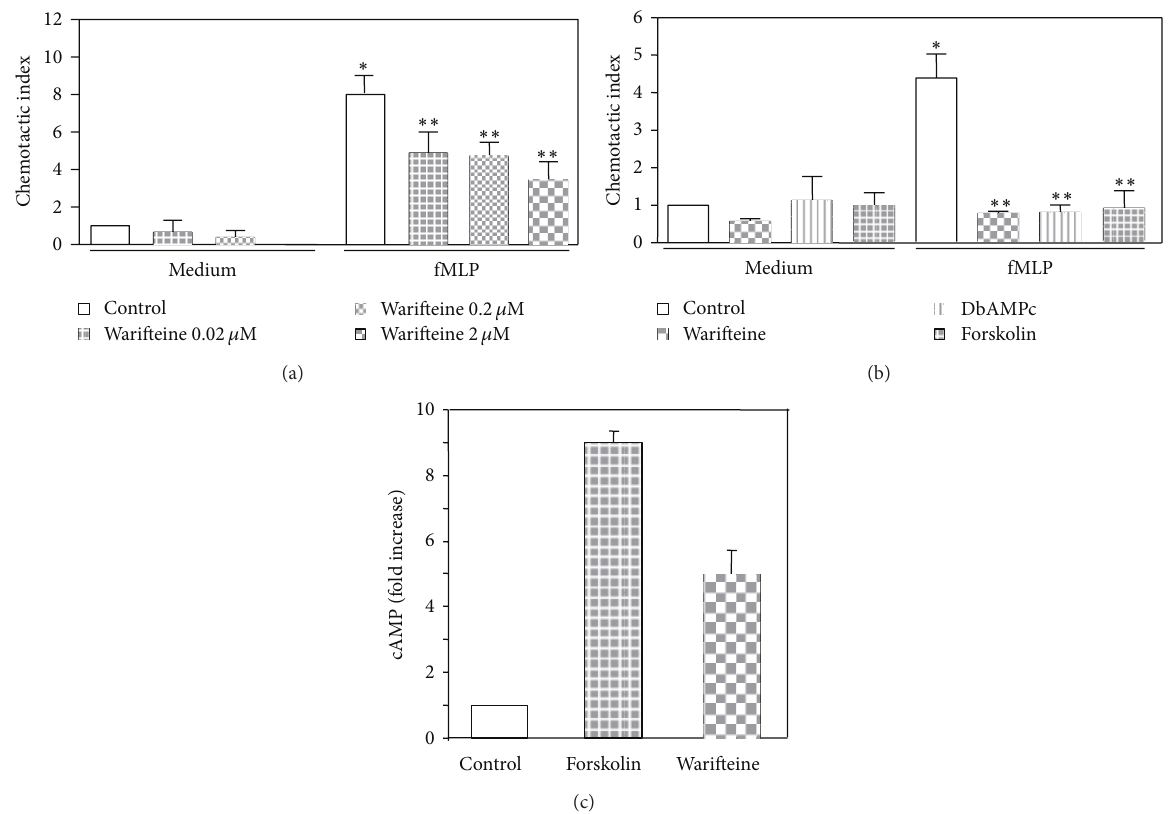
Figure 7: Inhibition of neutrophil migration in the presence of warifteine and induction of increased intracellular cAMP levels. (a) Solutions of chemoattractant (fMLP) were added to a 24-well plate. A neutrophil suspension was obtained and either left untreated or incubated with the indicated doses of warifteine. Theses samples were added to transwell inserts which were placed into the fMLP filled wells. Cell migration was determined by counting cell number in the outside (fMLP) compartment using a hemocytometer. The chemotactic index was calculated for each sample. Data shown indicate the mean value obtained from two independent experiments. ∗ 𝑃 ≤ 0.05 when comparing untreated and fMLP-stimulated cultures; ∗∗ 𝑃 ≤ 0.05 when comparing data from warifteine-treated and untreated cultures. (b) Samples obtained as described in (a) were incubated with warifteine, DbAMPc, or forskolin. Cultures were set up as in (a). Pretreated cell samples were added into a transwell insert placed in fMLP containing wells (outside compartment). The chemotactic index is shown. (c) Neutrophil cultures were incubated with either forskolin or warifteine. Control cultures received no pretreatment. Intracellular cAMP levels were measured by a competitive binding assay. Data indicate the fold increase of cAMP levels compared to untreated controls (set as